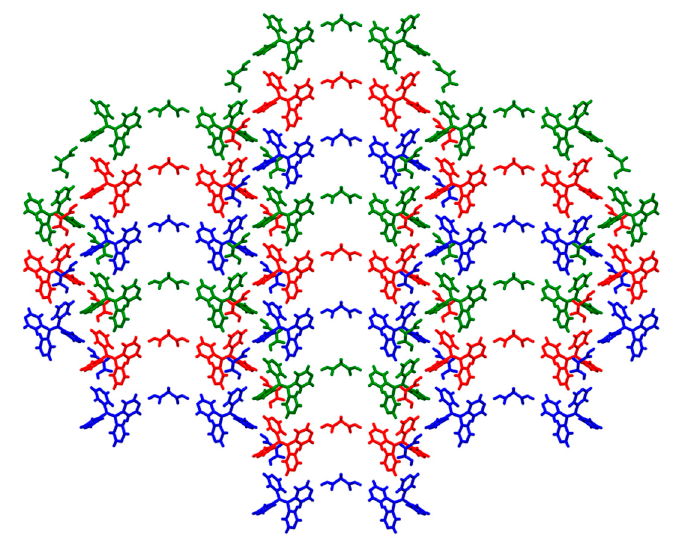
Figure 6. Interdigitation of three (6,3) nets in 7 (malonic acid) 1.5 . Three identical independent (6,3) networks are color coded red, green, and blue.